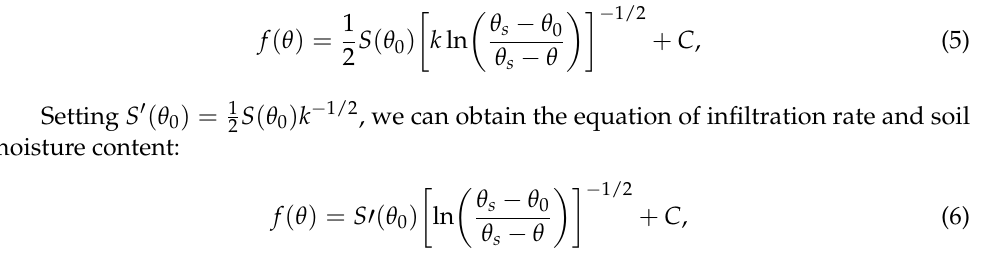
Figure 5. Relationship between fitted 𝜃 0 and measured initial soil moisture (each circle corre- sponds to an experimental scenario). 3.2. Relationship between Infiltration Rate and Soil Moisture Content In the previous analysis, the temperature of each soil layer was almost the same as the indoor temperature, and we focused on the change in average soil moisture content at the depth from 0 to 25 cm. As shown in Table 1, the average soil moisture content had a relatively obvious correlation with the soil moisture content at different depths. However, the rainfall infiltration process mainly occurs on the surface of soil, so the relationship between infiltration rate and soil moisture content will be affected by the depth of soil. Overall, infiltration rate and soil moisture content have an obvious negative correlation, and with the increase in soil depth, the correlation between infiltration rate and soil mois- ture content gradually decreases, and the change in soil moisture content below 20 cm had no significant impact on the infiltration rate, as shown in Table 1. Therefore, in the following analysis, we focused on the relationship between surface soil moisture content and infiltration rate. Table 1. Correlation coefficient of average of soil moisture and infiltration rate with soil moisture at different depths.